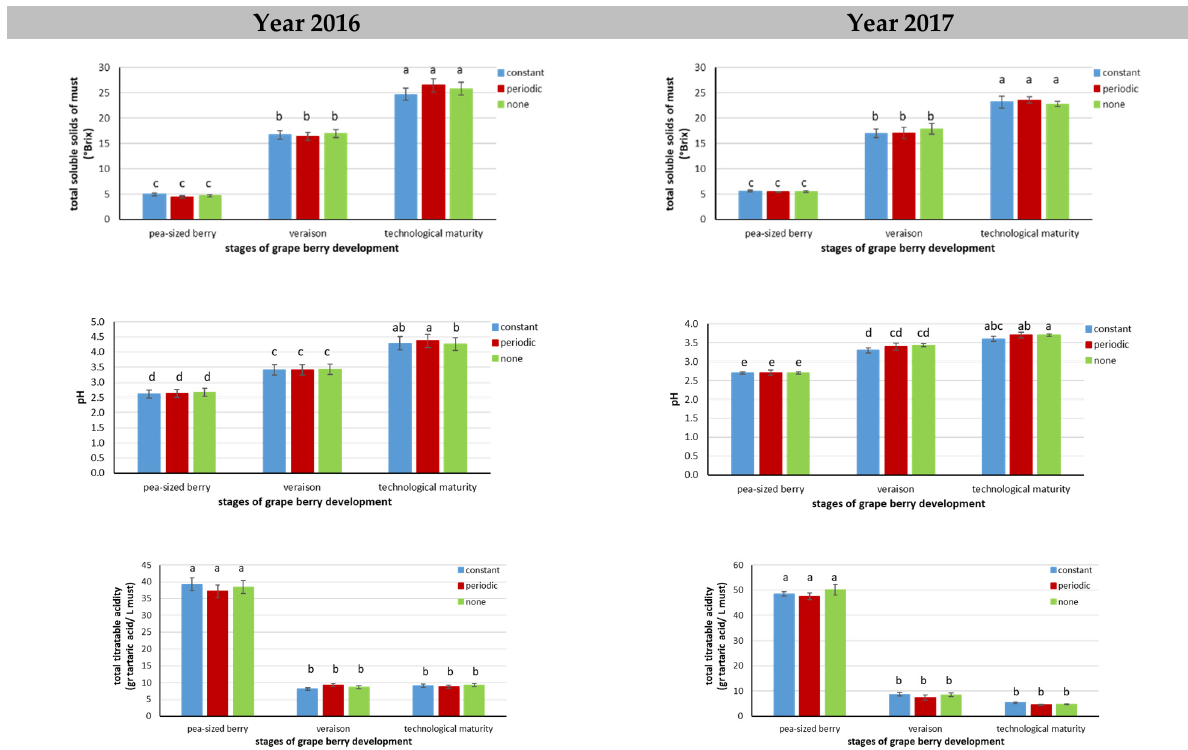
Figure 10. The effect of different wildflower meadow harvest treatments (constant, periodic, or none) on the qualitative characteristics of the grapes (total soluble solids of must, pH, and titratable acidity) during three stages of grape development (pea-sized berry, veraison, and technological maturity) in 2016 [49] and 2017. Within each measurement, statistical differences are denoted by different letters (Tukey HSD, at p < 0.05, n = 12).